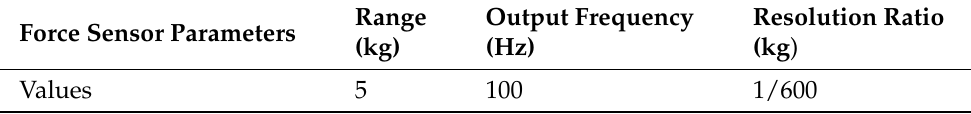
Table 3. Force sensor parameters.